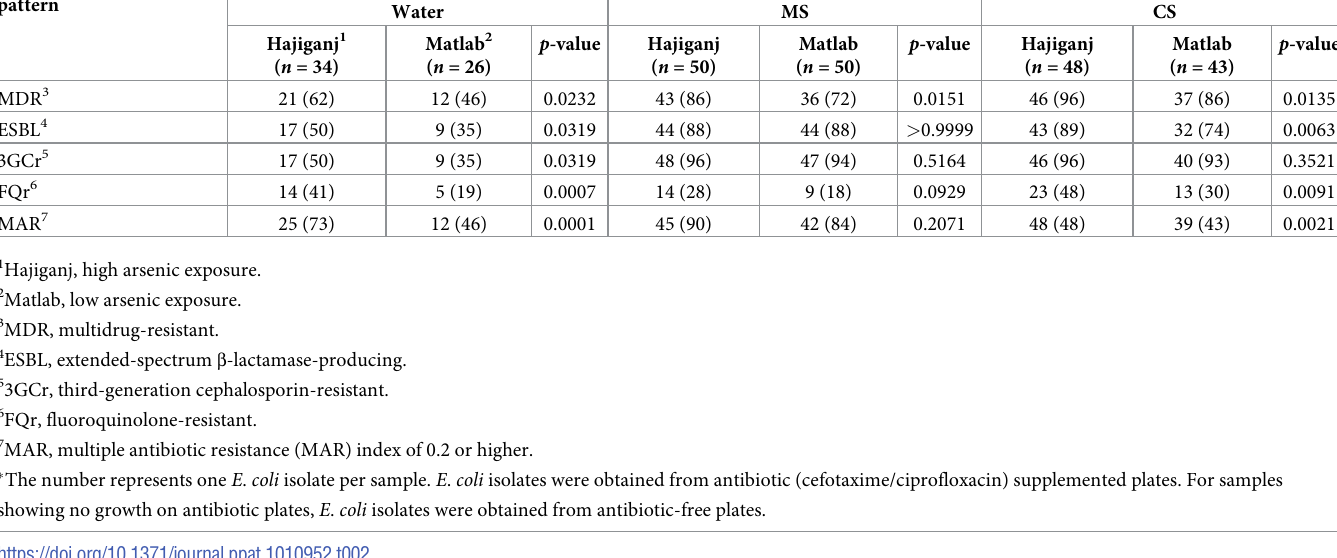
� No. (%) of E . coli isolates from Water MS CS Hajiganj 1 Matlab 2 p -value Hajiganj ( n = 34) ( n = 26) ( n = 50)